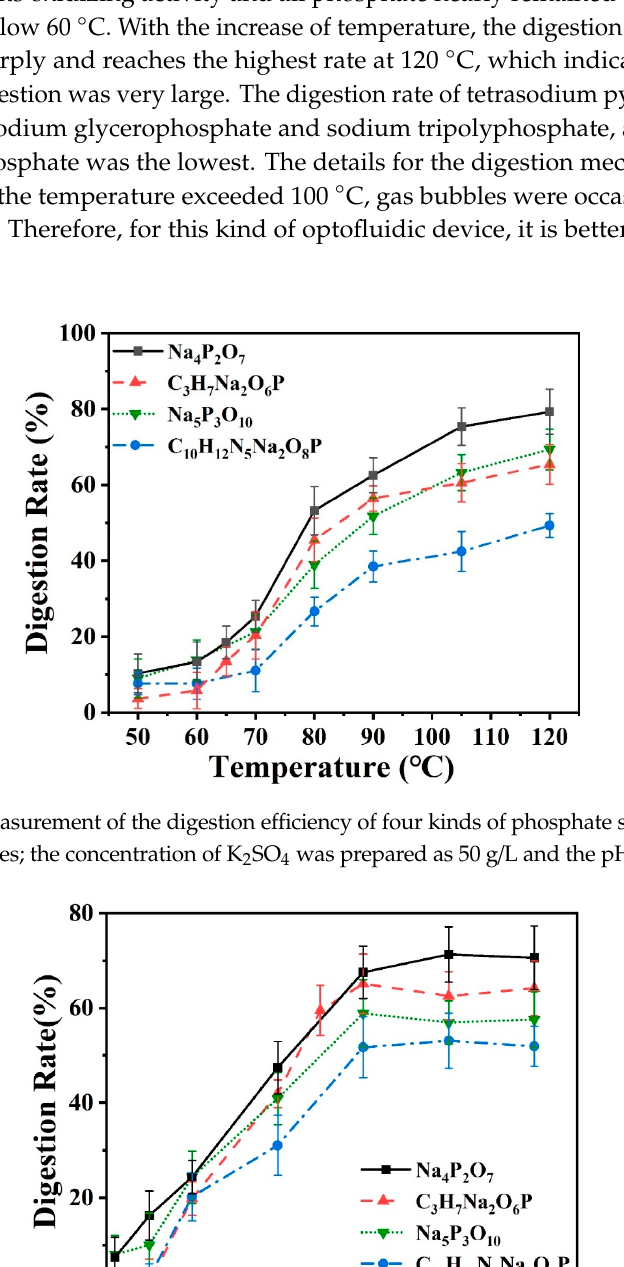
Figure 6. Online measurement of the digestion efficiency of four kinds of phosphate solution samples under different concentrations of the oxidant at the digestion temperature of 90 °C and pH value of 11.4.